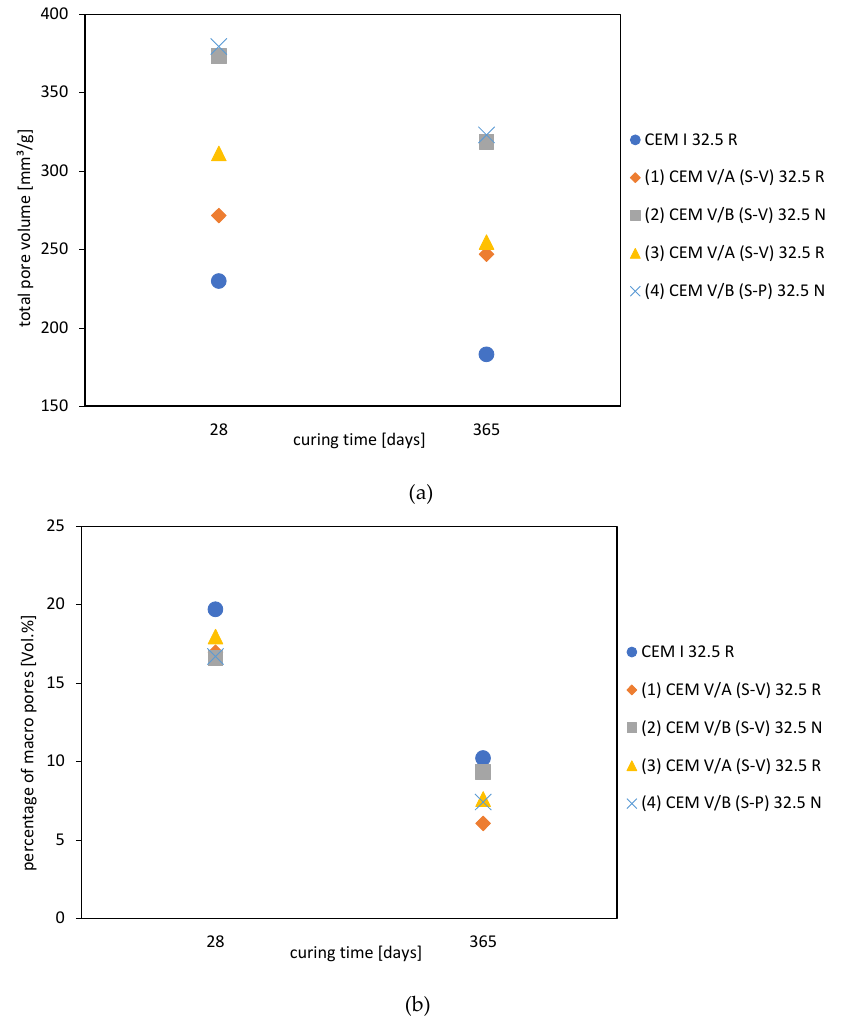
Figure 6. Development of total porosity ( a ) and percentage of macro-porosity ( b ) for a curing time of 28 and 365 days.